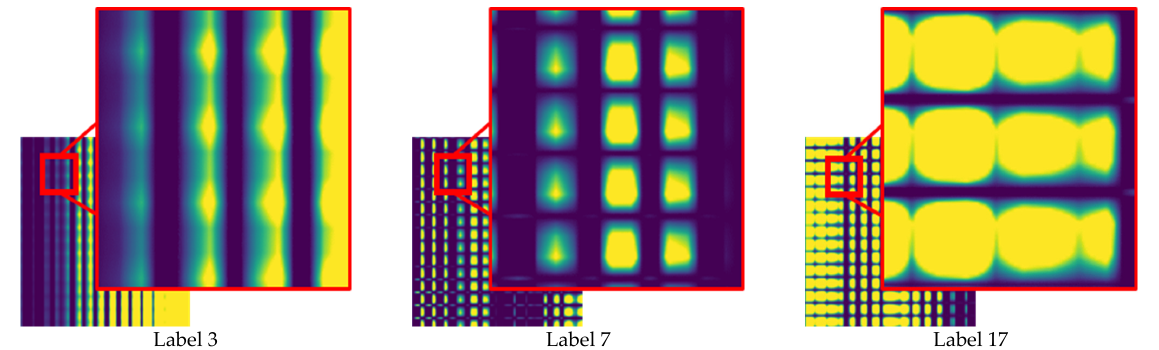
Figure 5. Example of the magnified 𝑆𝐵𝐼𝐷𝑃 of some samples in Figure 4.